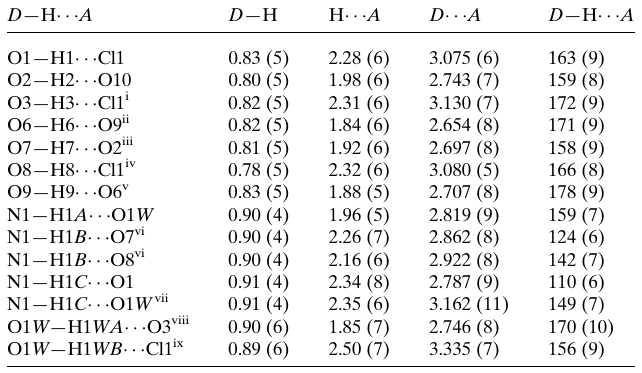
Table 3 Additional D —H (cid:2)(cid:2)(cid:2) A contacts (A˚ , (cid:5)